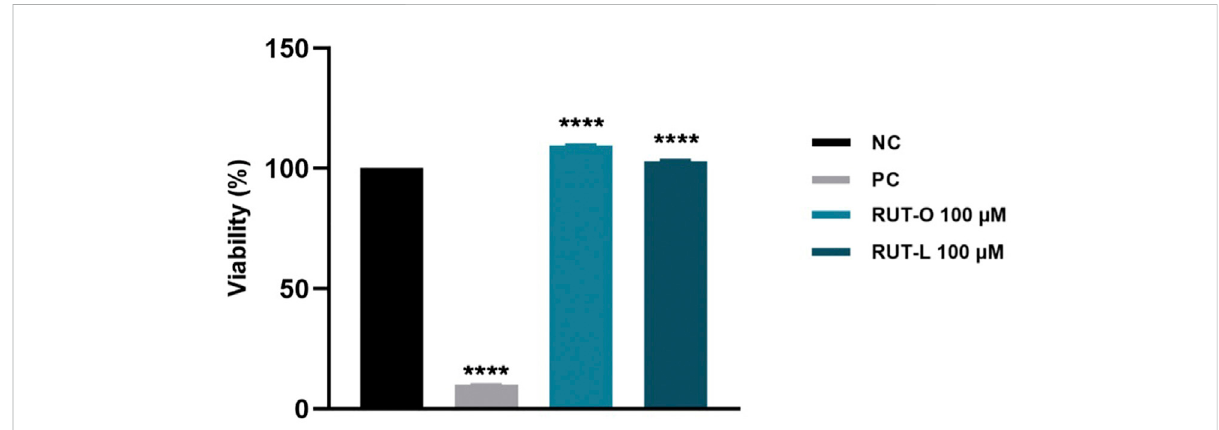
FIGURE 7 Viability percentage of EpiDerm skin model inserts (EPI-212-SIT) following treatment with RUT-O and RUT-L — 100 µM. One-way analysis of variance (ANOVA) followed by the Dunett ’ s post-test was employed to determine the statistical differences between sample-treated inserts and